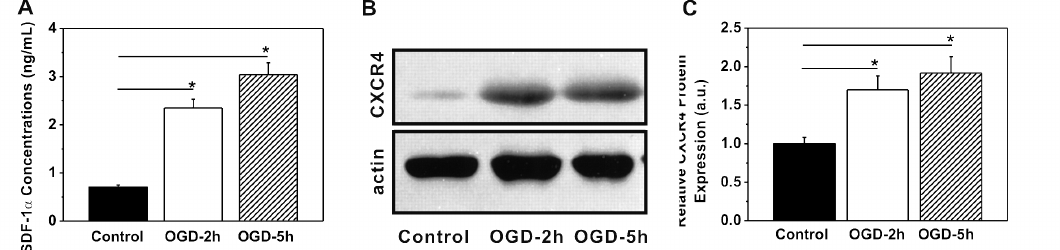
Figure 6. (A) The content of SDF-1α in the conditioned mediums of the three groups. (B) Western blot analysis of CXCR4 protein of NSCs expression when treated with OGD for 2 h or 5 h. (C) Relative optical densities of CXCR4 bands. Data were presented as mean ± S.E.M. *p < 0.05 vs control.